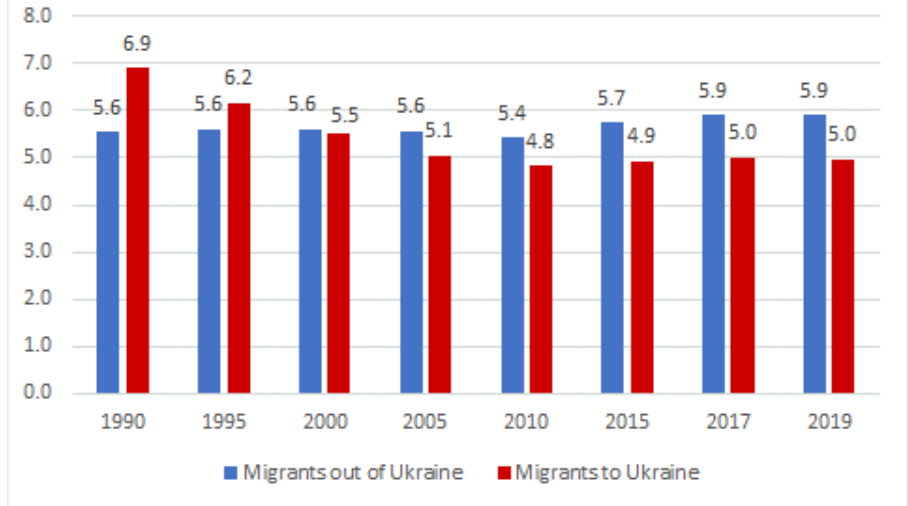
Figure 2. Stocks of immigrants in Ukraine and emigrants from Ukraine based on the country of birth criterion, in